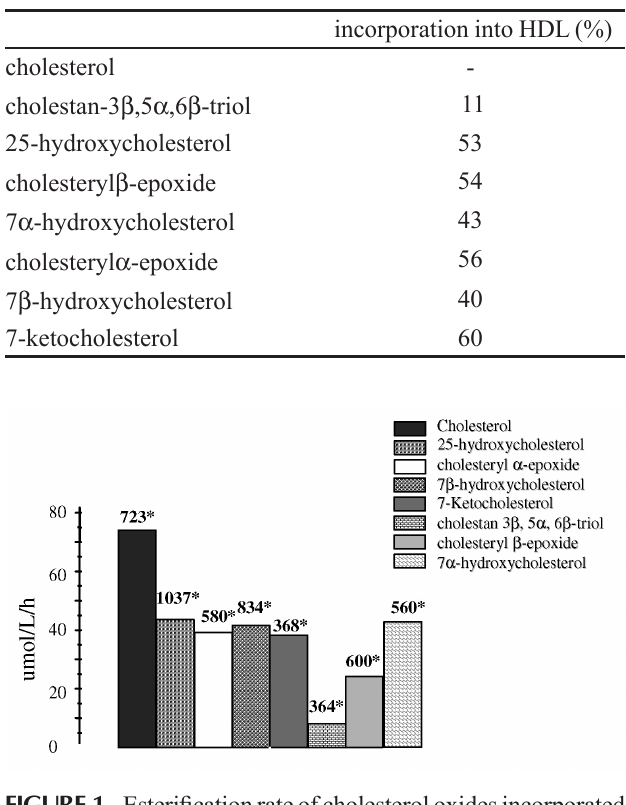
FIGURE 1 - Esterification rate of cholesterol oxides incorporated into HDL, in relation to an HDL particle containing no cholesterol oxides. *Initial concentrations of cholesterol oxides (uM) incorporated into HDL.